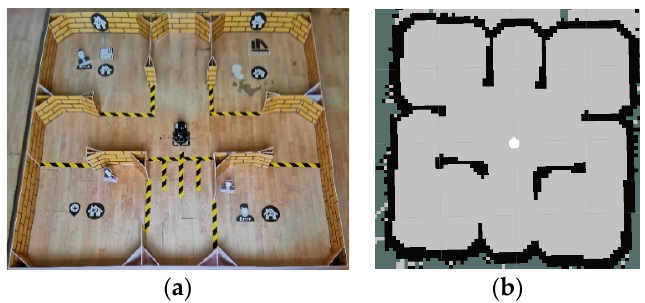
Figure 15. The experimental environment we built: ( a ) The real experimental scenario; ( b ) The corresponding environment map built by TurtleBot3 in Gmapping algorithm.